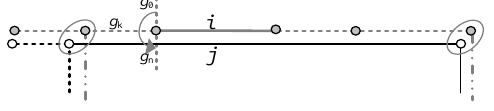
Figure 5. Matching Growing from unmatched nodes